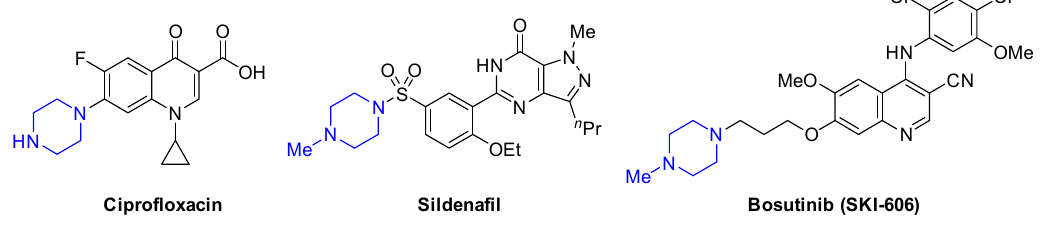
Figure 1. Piperazine-containing drugs.